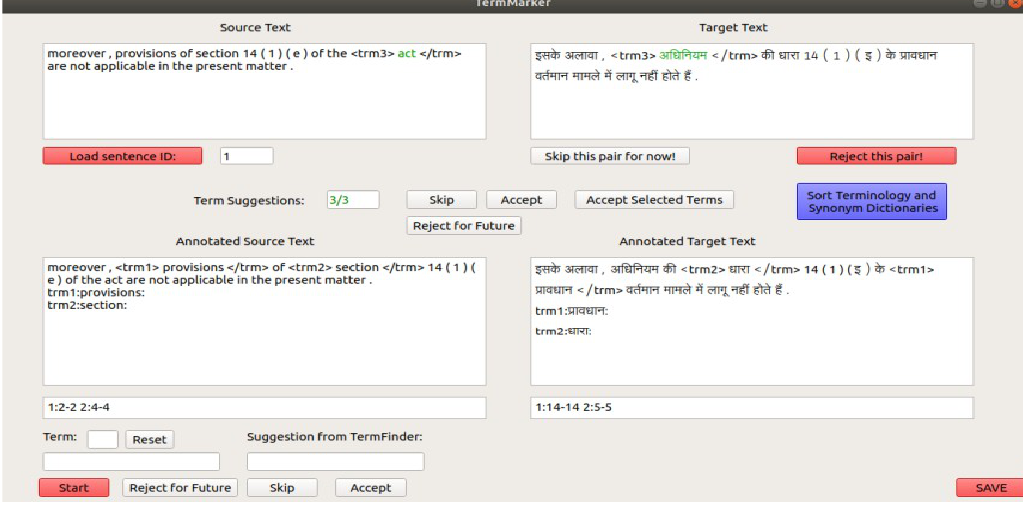
Figure 1. TermMarker.